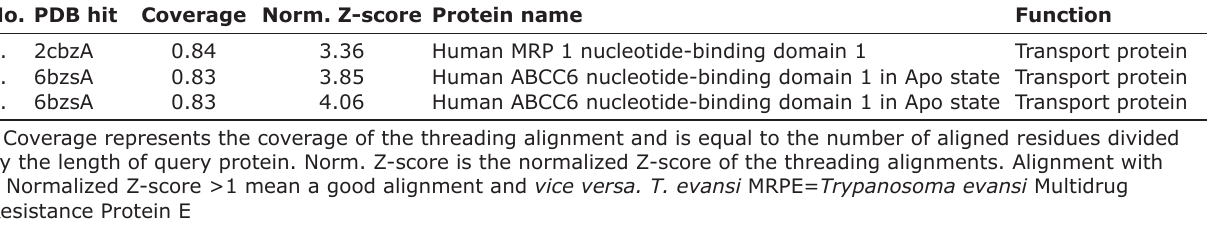
Table-2: The protein threading results of the T. evansi MRPE protein. No. PDB hit Coverage Norm. Z-score Protein name